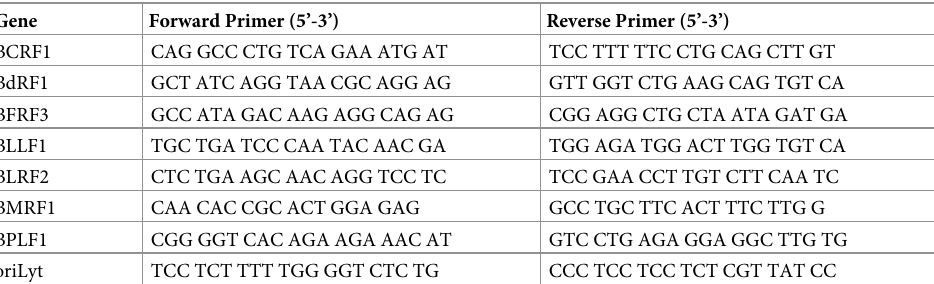
Table 1. Sequences of primers used in real time PCR